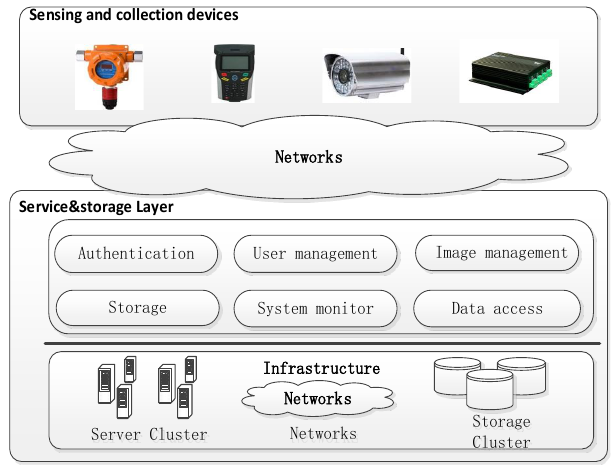
Figure 5. The architecture of the service and storage